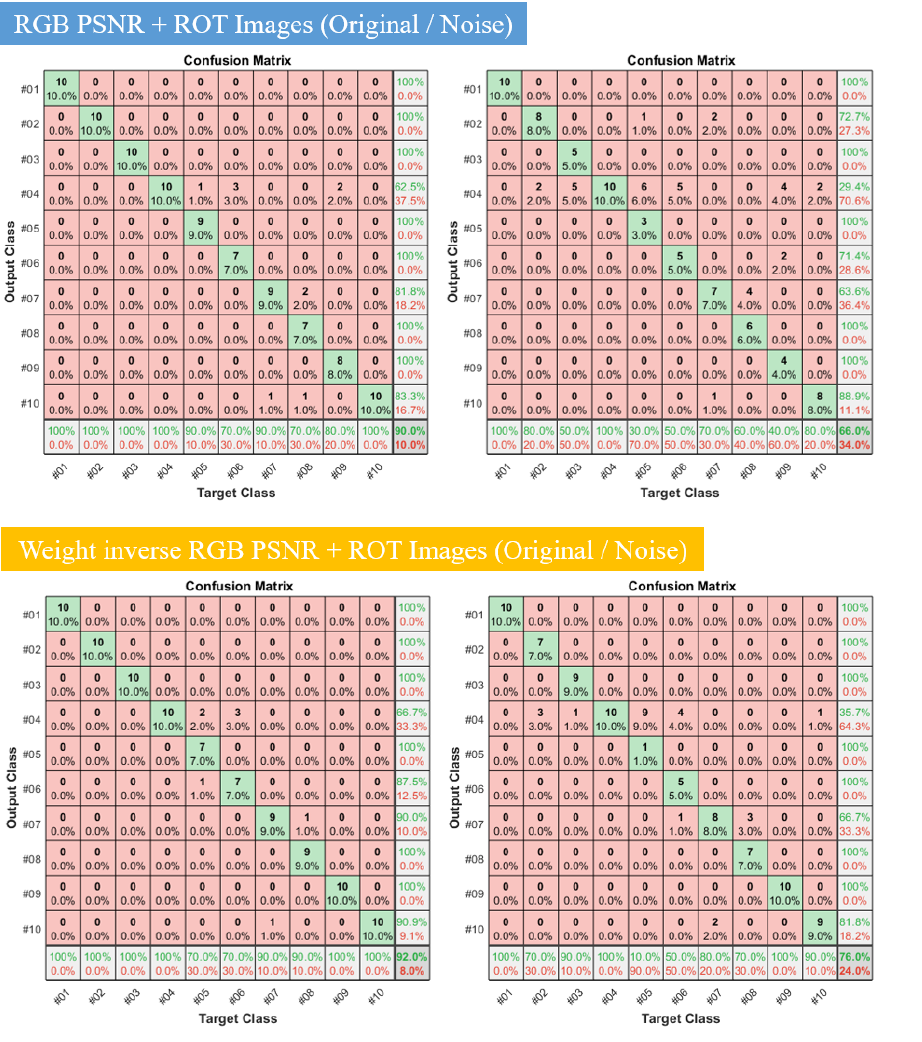
Figure 10. Comparison of confusion matrix